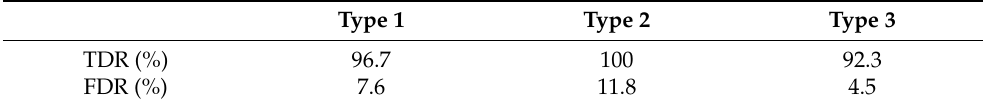
Table 3. Defect detection capabilities of our method.